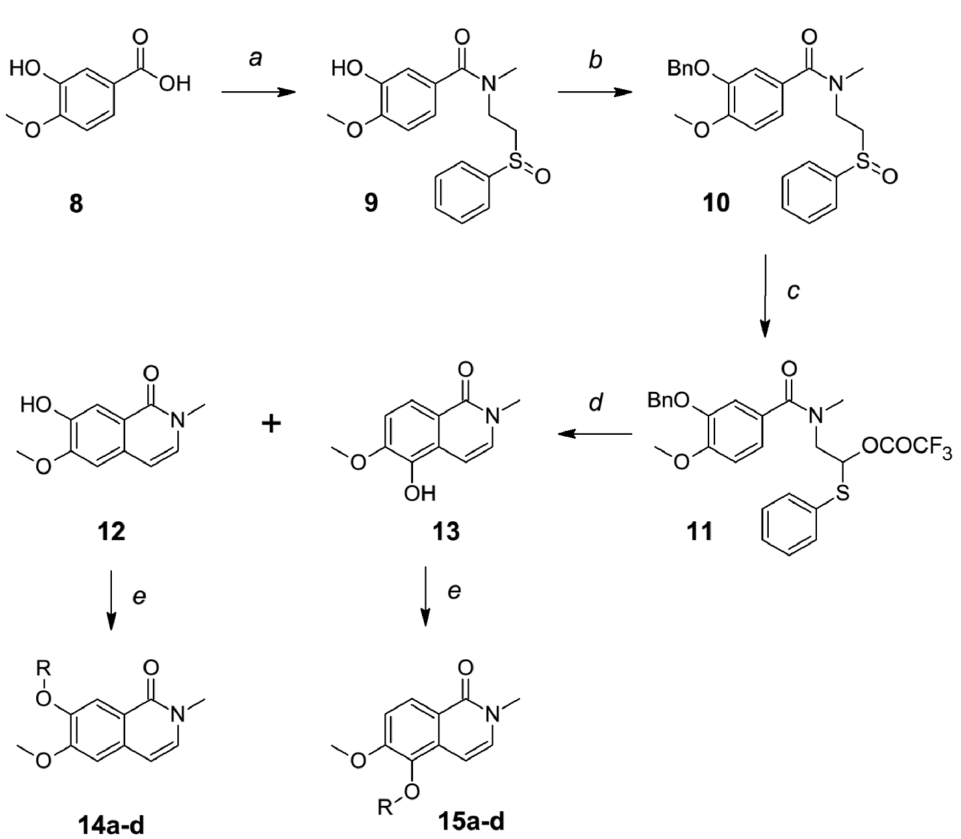
Figure 2. Synthesis of isoquinolinones 14a–d and 15a–d. a) DIC, 2 , CH 2 Cl 2 , r.t. 84–91%; b) BnBr, K 2 CO 3 , DMF, 91% for two steps; c) TFAA, CH 2 Cl 2 , 0 ˚ C; d) TsOH, toluene, heat, yields for two steps: 37% for 12 , 24% for 13 . e) RX, K 2 CO 3 , DMF, r.t., , 95%.